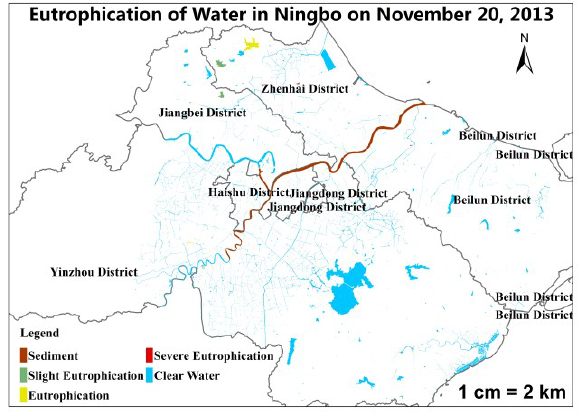
Figure 3. Eutrophication of Water Bodies in Ningbo on